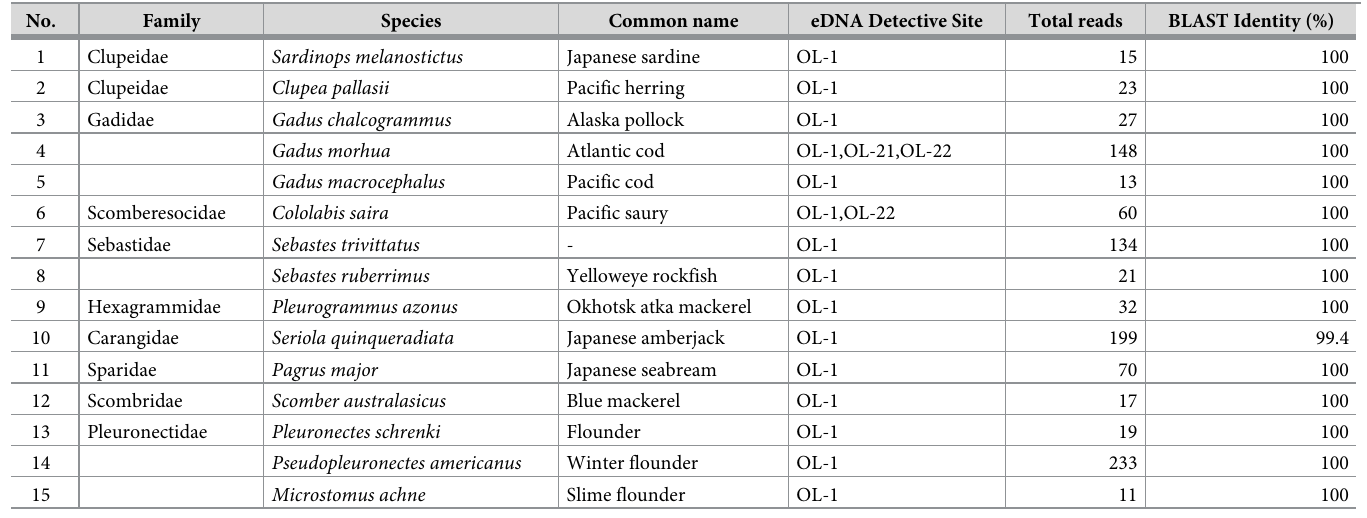
Table 4. Marine fish species detected using eDNA metabarcoding and the total reads by high-throughput parallel DNA sequencing (HTS). No.